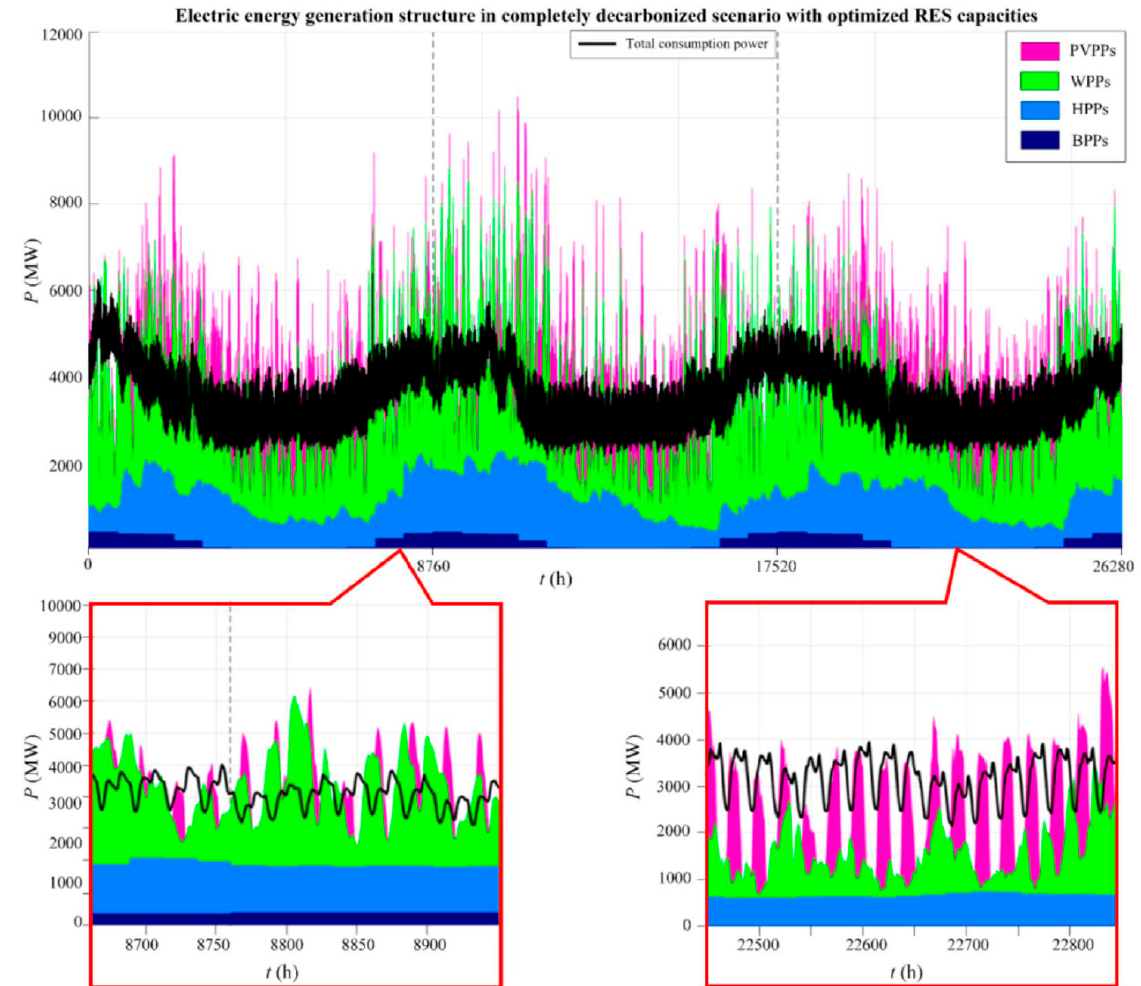
Figure 8. Different generation technology shares in the total generation profile. Table 4. The imbalance power profile characteristics for the analyzed three-year reference time pe- riod.